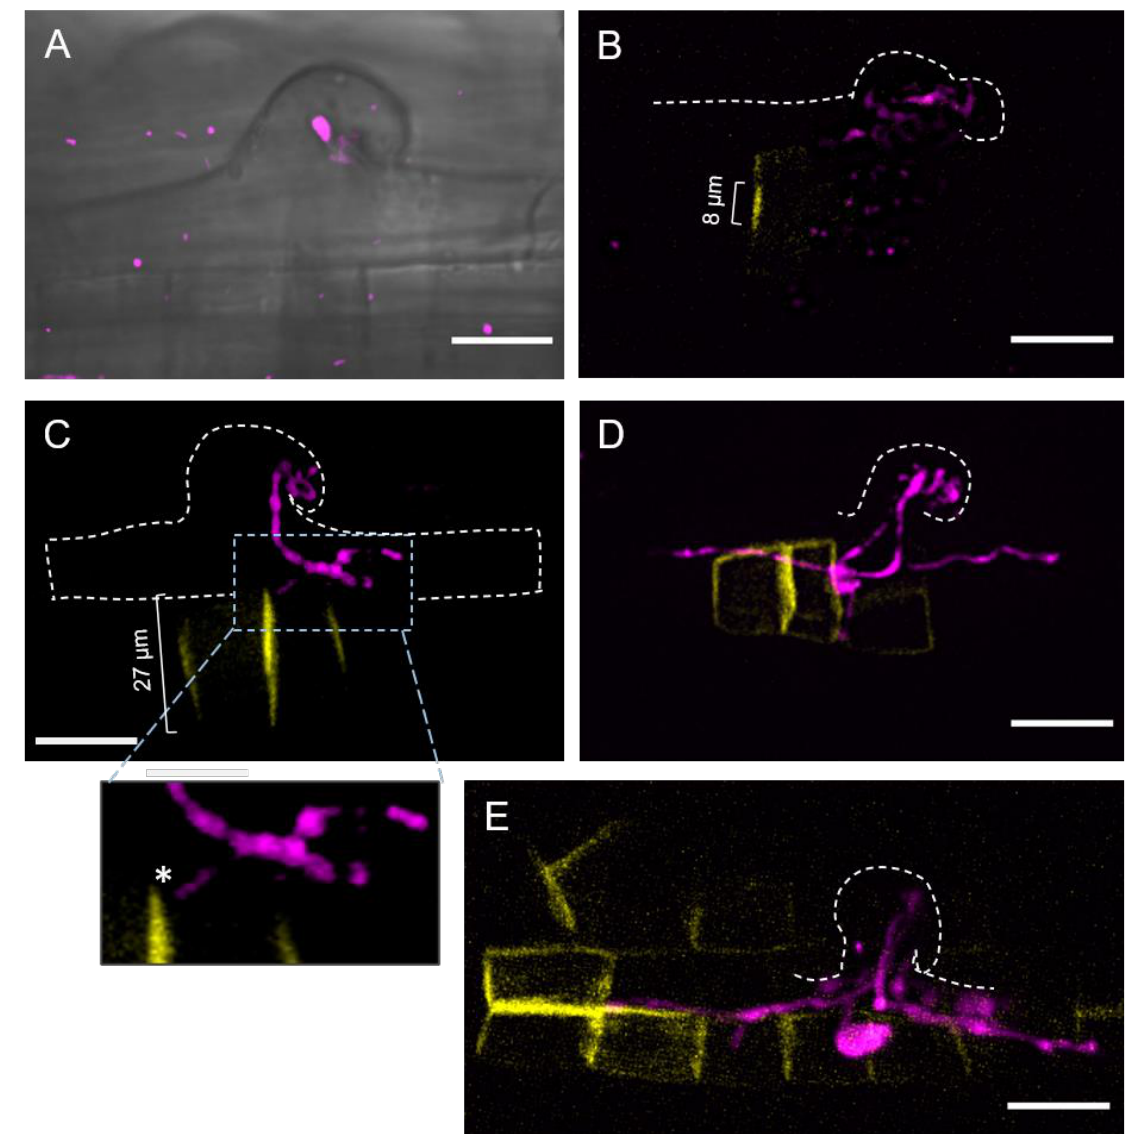
Figure 5. Visualization of the cell plate in subepidermal (S-E) cells underlying the epidermal infection at stages II and IV of the infection thread (IT) progression. The 2D projections of the epidermal infection site in P. vulgaris transgenic roots expressing YFP- Pv KNOLLE and inoculated with R. etli CE3-DsRed pMP604 (4 dpi). Images are representative of each IT progression stage. ( A ) Stage I. Fluorescence image was merged with the differential interference contrast (DIC) image to highlight the position of the microcolony in the context of the curled root hair. No YFP- Pv KNOLLE signal was detected in the underlying S-E cells, indicating they are not cytokinetic. ( B ) Stage II. YFP- Pv KNOLLE is labeling a nascent cell plate, suggesting the S-E cell is at early telophase. ( C ) Stage III. The cell plate is expanded to the periphery of the S-E cell underlying the infected root hair. The tip of an IT branch has reached the base of the root hair and it is close to the zone of the putative fusion of the cell plate with the parental plasma membrane, indicated with an asterisk in the inset. ( D ) Stage IV. The IT has exited the root hair to penetrate a post-cytokinetic underlying S-E cell, meaning the cell plate formation has concluded. ( E ) The IT invades several cytokinetic cells adjacent to the epidermal infection site. Length of the respective cell plate in ( B , C ) is indicated. R. etli CE3-DsRed pMP604 is in pseudo-color magenta. Dashed white lines indicate the contour of curled root hairs. Bars = 20 µm.